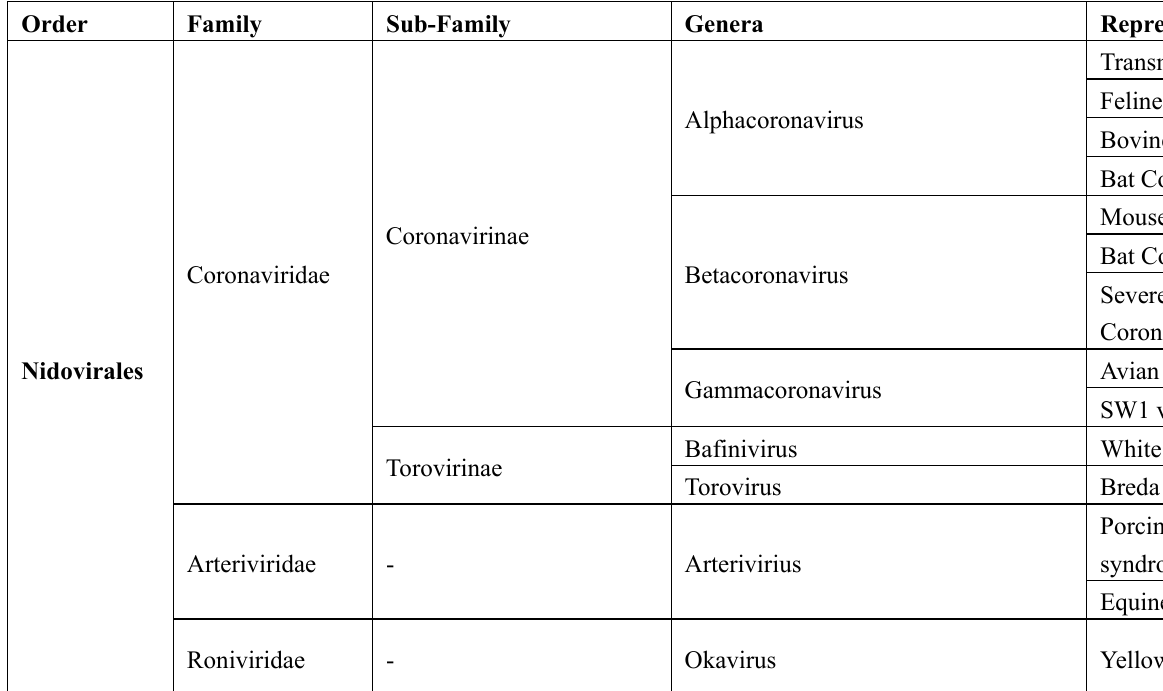
Table 1. Classification of